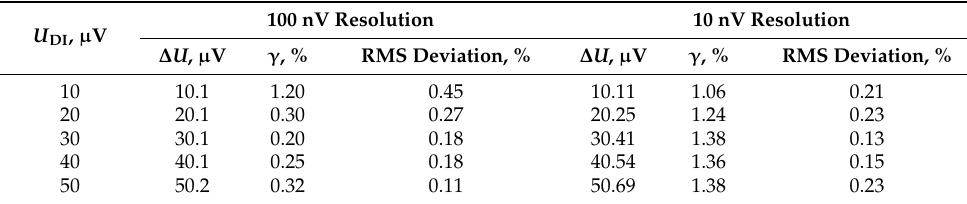
Table 4. Differential voltage at 100 and 10 nV resolutions.